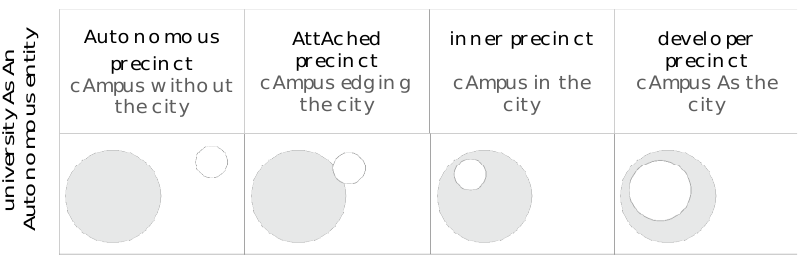
Figure 1 Types of university campuses that function as autonomous entities